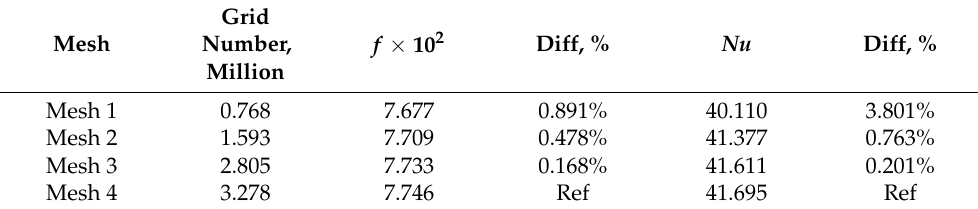
Table 1. Grid independence study.